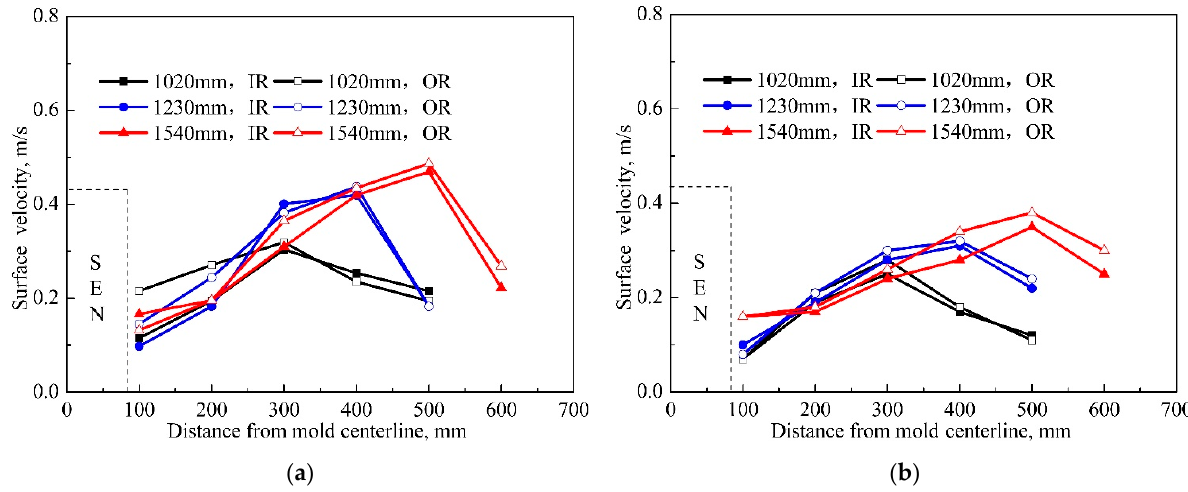
Figure 10. Comparison of practically measured free surface velocity at inner radius (IR) and outer radius (OR) using ( a ) 3P-0 SEN and ( b ) 3P-2 SEN.